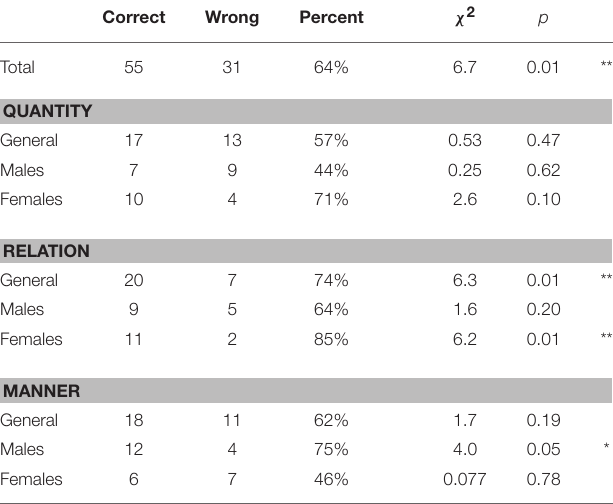
TABLE 3 | Effect of violations and gender on the results of the Turing